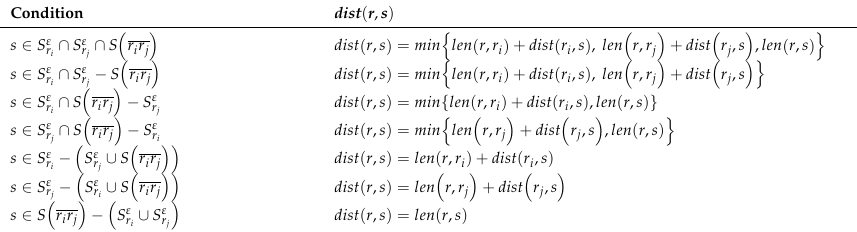
(cid:16) (cid:17) ∪ S ε ∪ S r i r j r j i (cid:3084) ∪ (cid:1845) (cid:3084) ∪ (cid:1845)((cid:1870) (cid:3045) (cid:3285) (cid:3036) (cid:1870) (cid:3037) ) . (cid:3284)